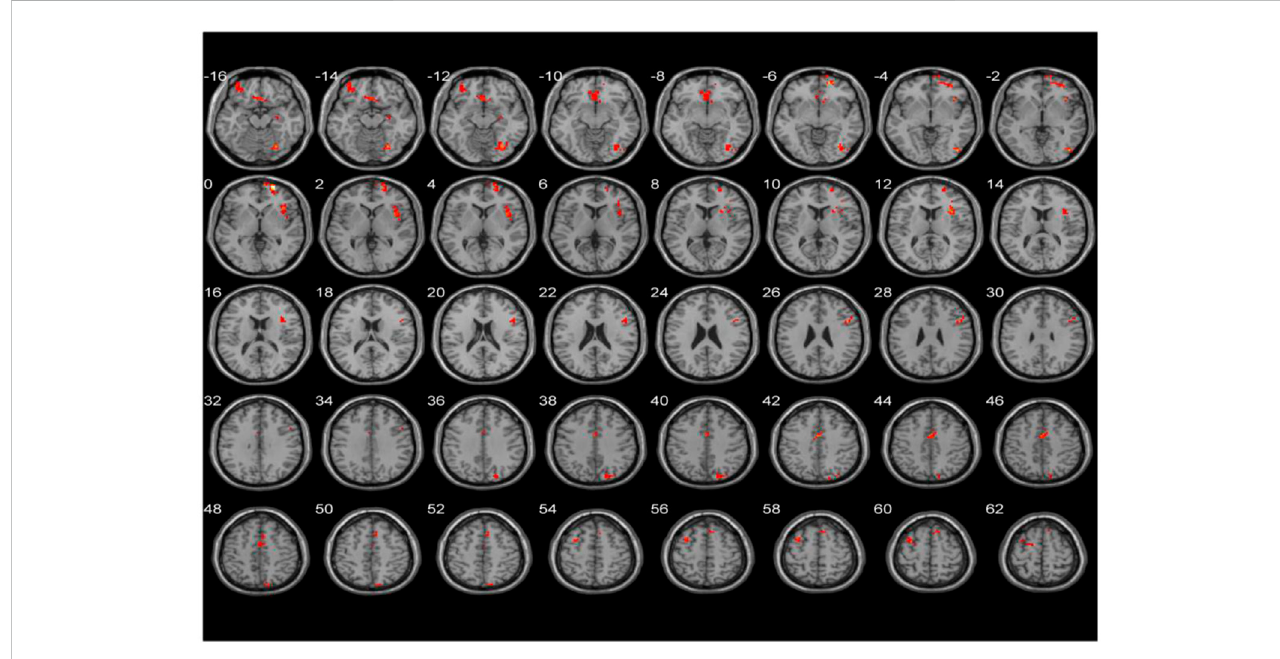
FIGURE 2 Signi fi cantplane diagramoftheinteractioneffect offALFFvalues.Note:The colorbarrepresentsthebrainareawith signi fi cantinteraction,thestatistical threshold was set to p < 0.001, and the number of voxels was > 20. fALFF: low-frequency amplitude